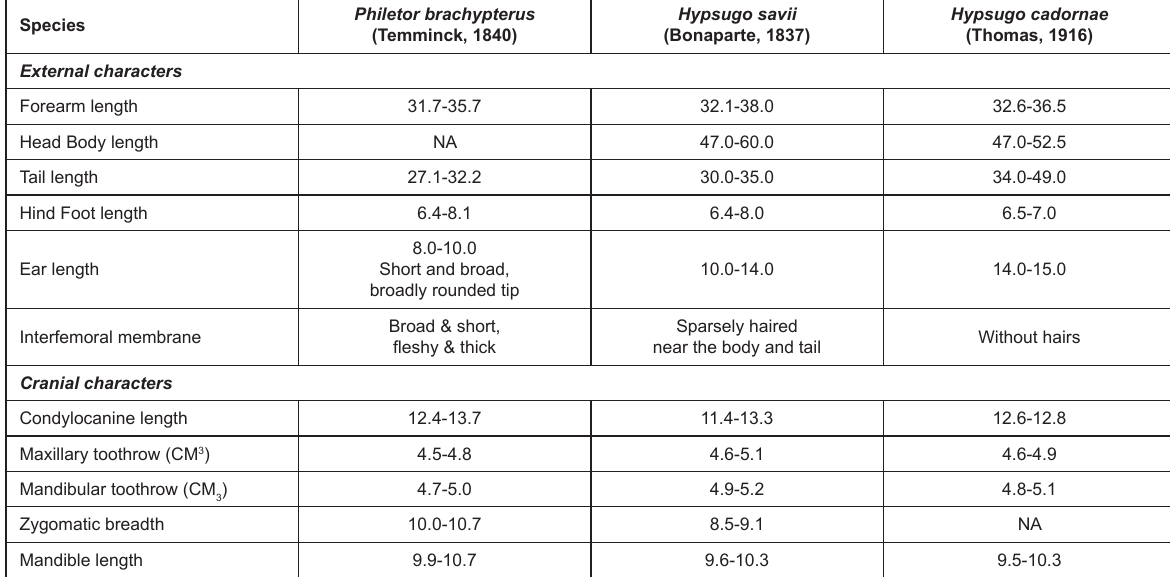
Table 7.8 (Contd.). Diagnostic morphological characters of species of the genera Philetor and Hypsugo present in South asia